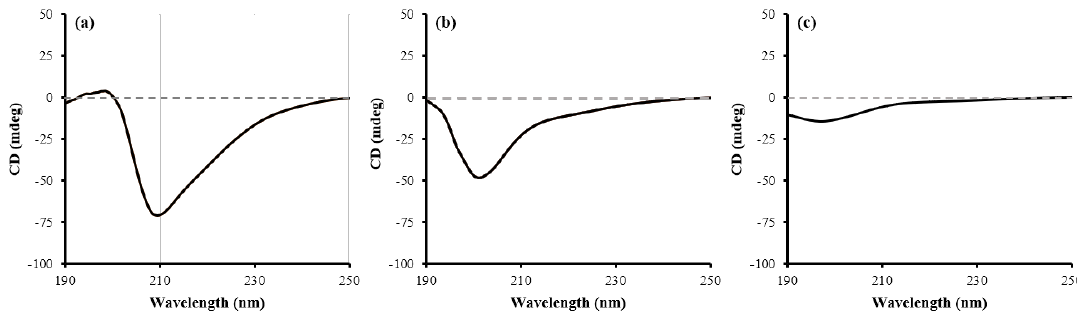
Figure 5. CD spectra of three types of tIK peptides, ( a ) tIK-9mer, ( b ) tIK-14mer, and ( c ) tIK-18mer. As the sequence lengthened from tIK-9mer to 18mer, the secondary structure tends to change from alpha-helix to random coil.